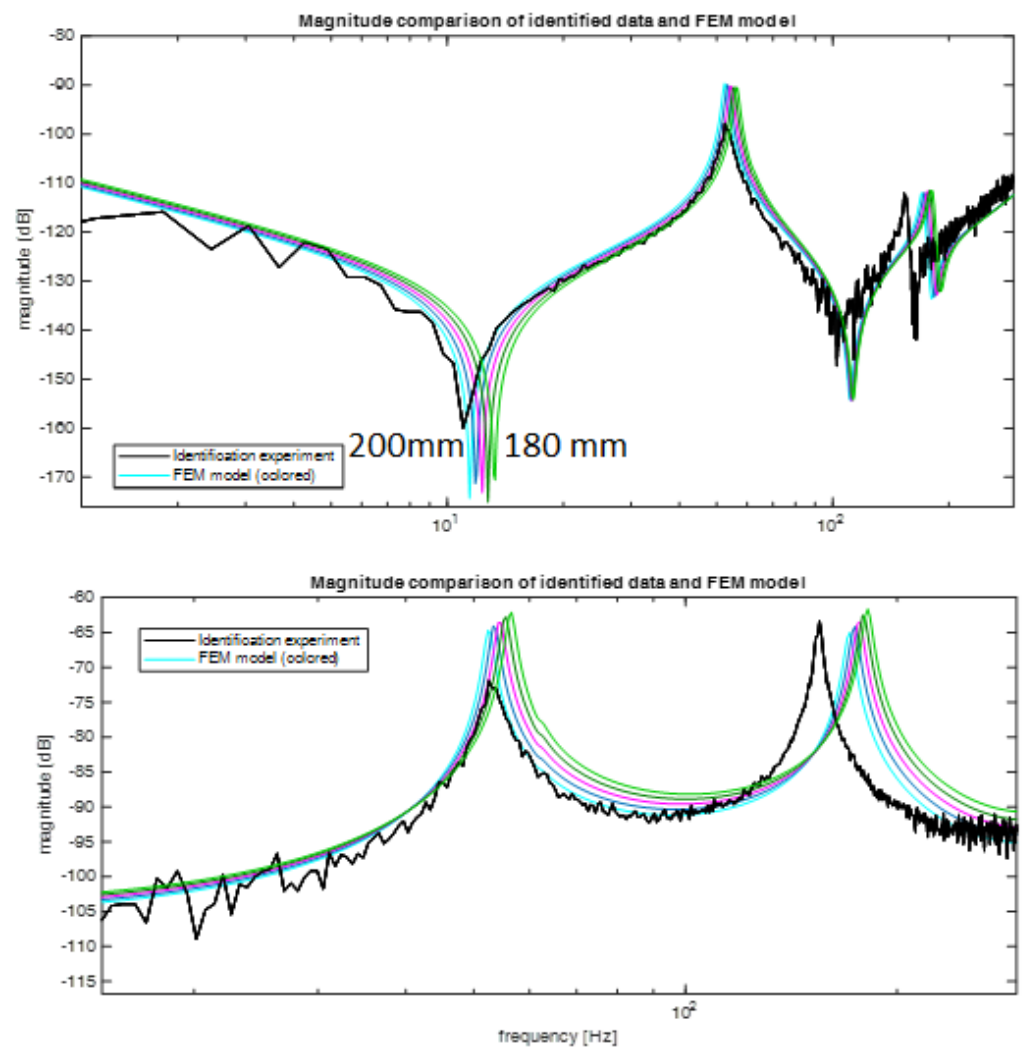
Figure 19. Assumed parametric-uncertainty: variable load mass position and its effect on the first two resonance modes location, showing the FRFs for motor and load side dynamics; the higher modes above 250 Hz frequencies correspond to actuator and manipulator base dynamics and remain